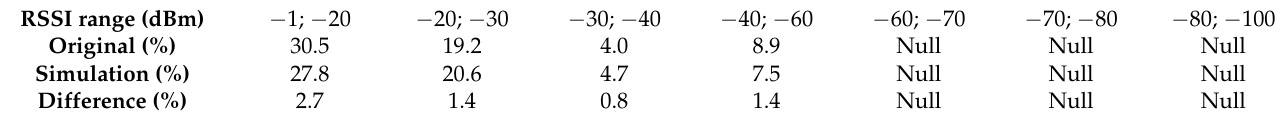
Table 5. Percentage of pixels in the heat map by RSSI ranges for antenna 2.